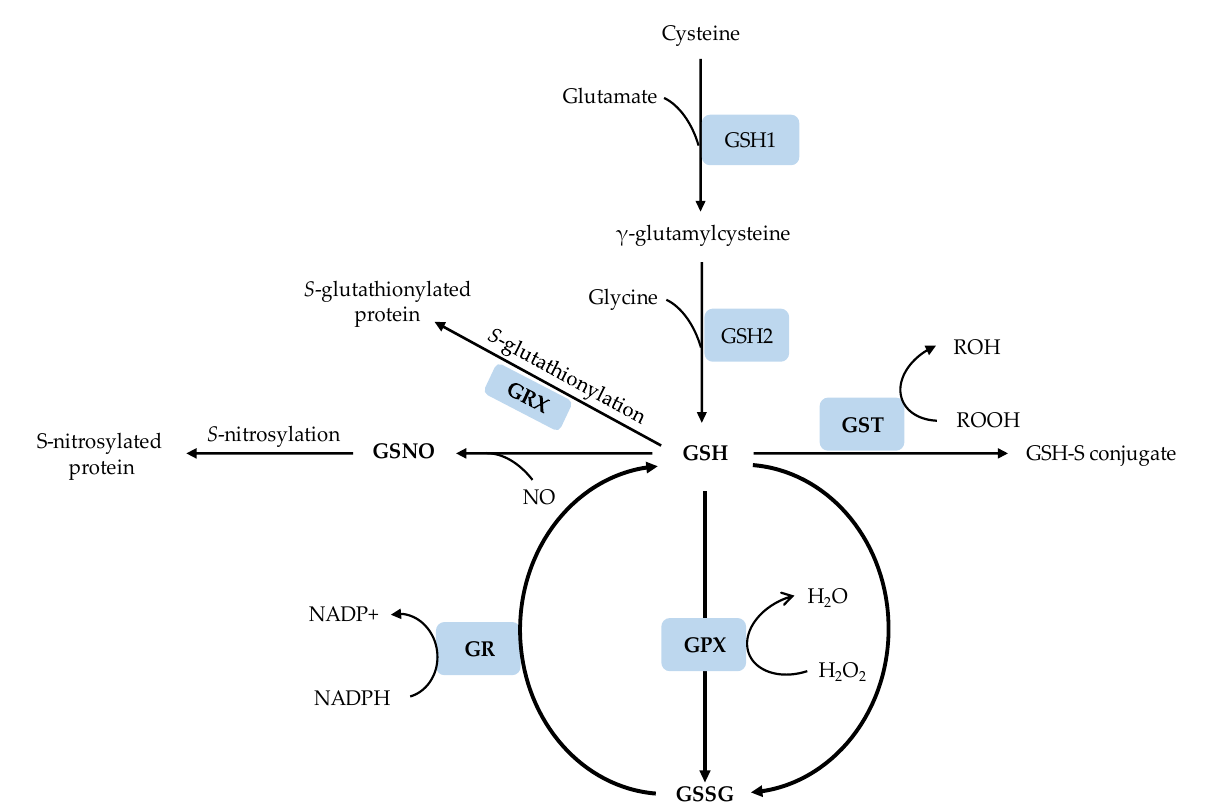
Figure 1. A schematic representation of GSH biosynthesis and metabolism. GSH1, γ -glutamylcysteine synthetase; GSH2, GSH synthetase; GSH, reduced glutathione; GSSG; oxidized glutathione; GST, glutathione-S-transferases; GPX, glutathione peroxidase; GRX, glutaredoxin; GR, glutathione reductase; GSNO, S -nitrosoglutathione.